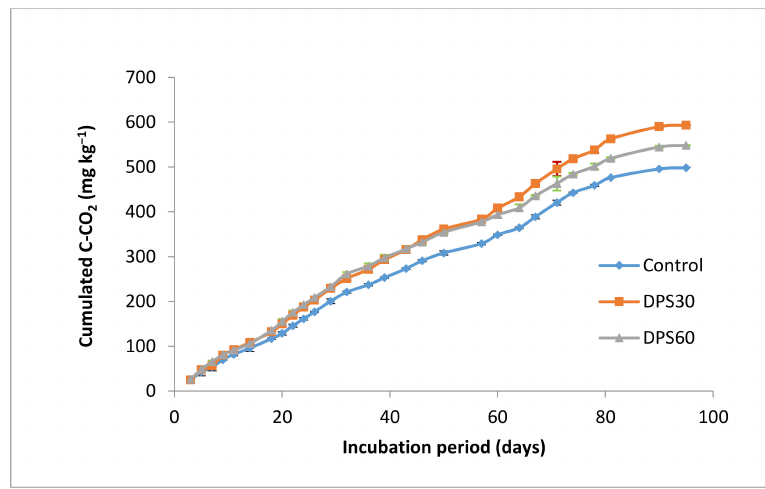
Figure 4. Cumulated carbon-carbon dioxide (C-CO 2 ) following two successive annual deinking paper sludge (DPS) amendments at two rates, 30 and 60 Mg ha − 1 (DPS30 and DPS60,